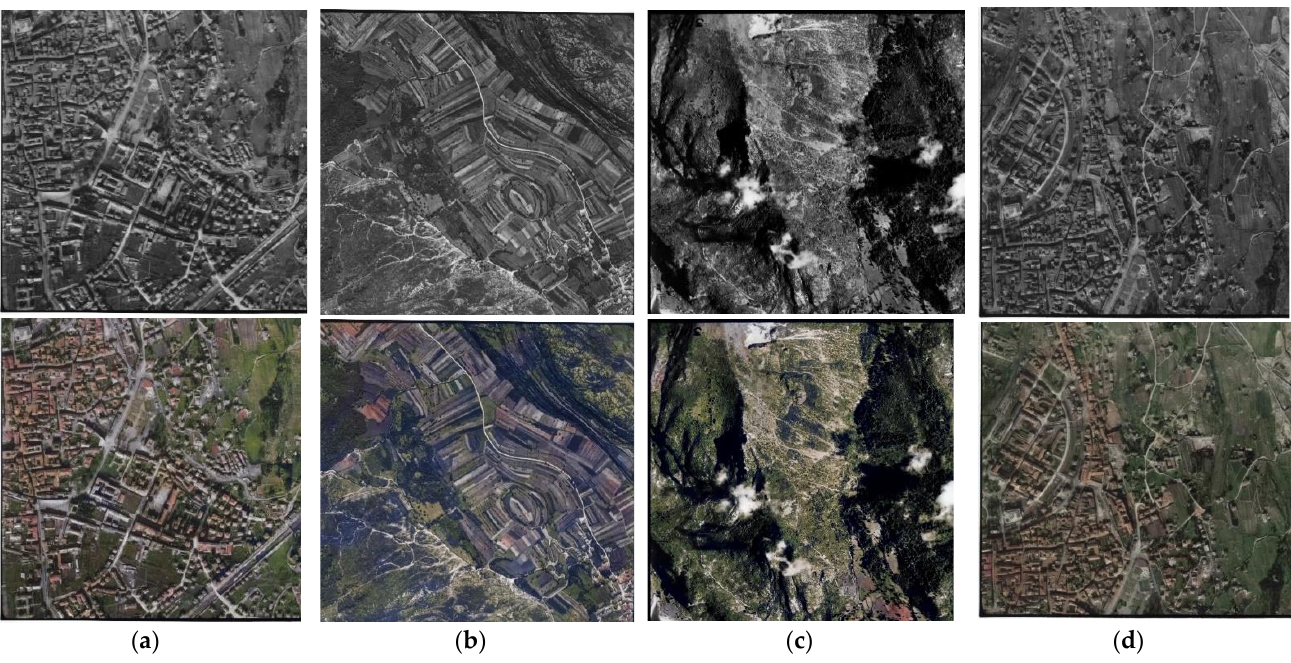
Figure 8. Some examples of historical grayscale images (first row) available in the TIME benchmark [19] colorized with the proposed Hyper-U-NET (second row), depicting mostly urban ( a and d ), rural ( b ), and mountainous ( c ) environments.